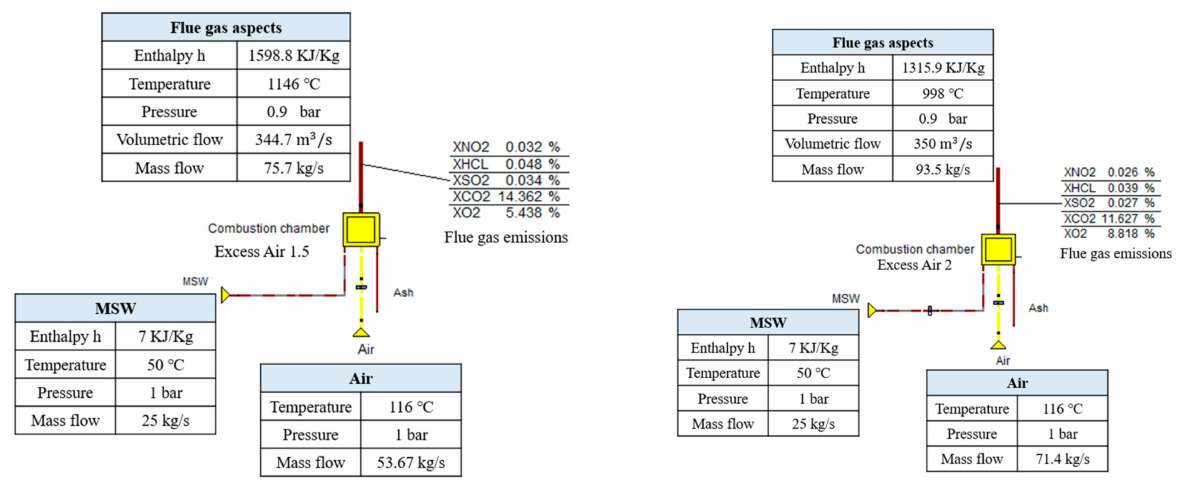
Figure 2. Simulated furnace in Ebsilon with two different amounts of excess air ratio; 1.5 ( left side of the figure) and 2 ( right side of the figure). This shows the effect of the excess air ratio on the mass flow of air required to be loaded into the furnace, the volumetric flue gas, flue gas temperature, and the emissions for the same MSW mass